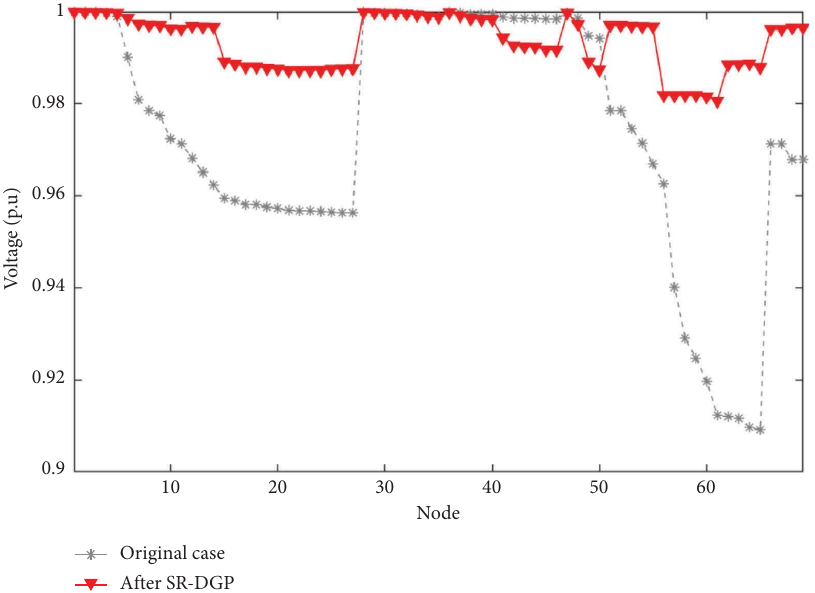
Figure 6: Voltage profles before and after SR-DGP for 69-node system.